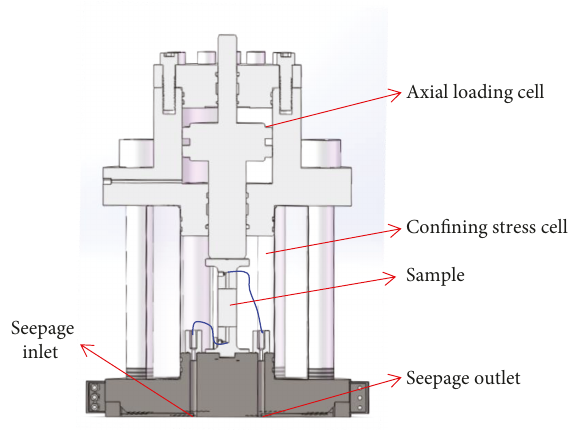
Figure 4: Schematic of triaxial compression